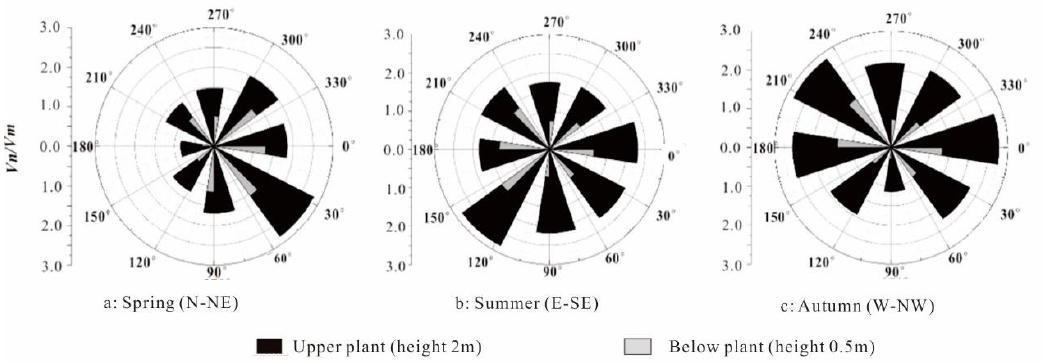
Figure 7. Airflow distribution of eight-azimuth orientation at different layers of H. rhamnoides in spring ( a ), summer ( b ) and autumn ( c ) .